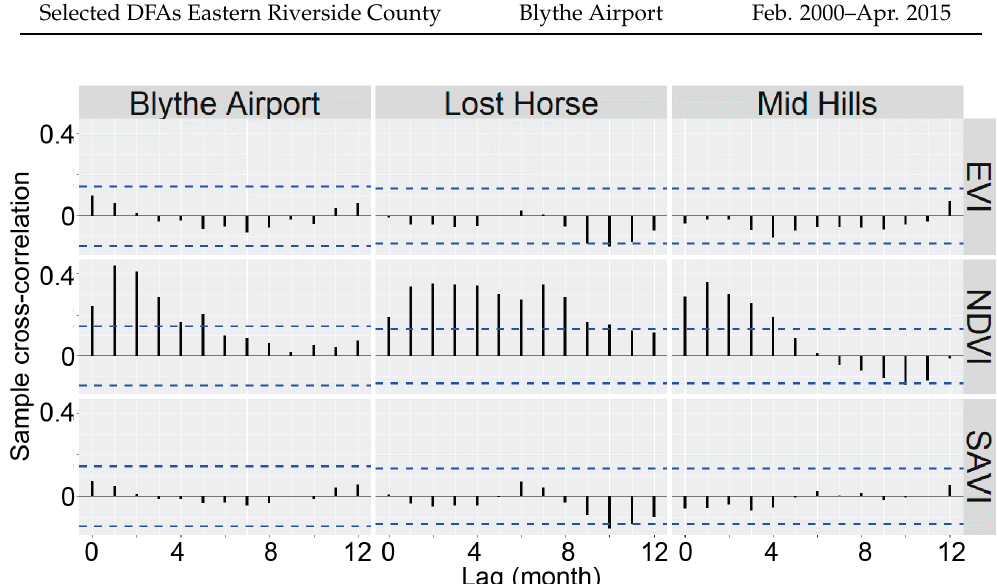
Figure 4. Cross-correlation of VIs and precipitation; horizontal bars indicate significance